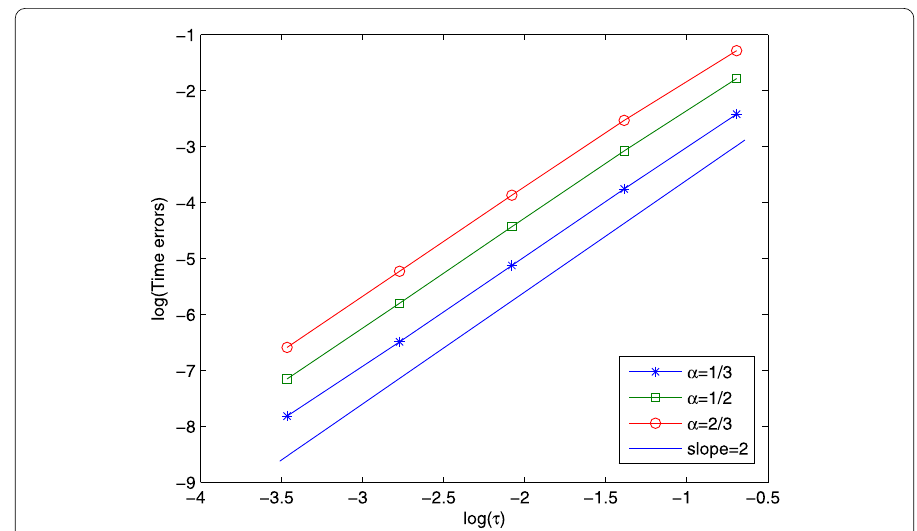
Figure 3 The error reduction in temporal direction of the scheme (8) for Example 3